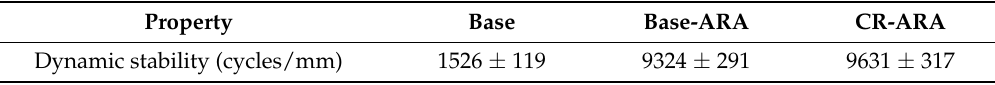
Figure 7. Rutting depth development in asphalt mixture slabs under repeated wheel tracking. Table 6. Dynamic stability of asphalt mix after wheel tracking test. Table 6. Dynamic stability of asphalt mix after wheel tracking test.